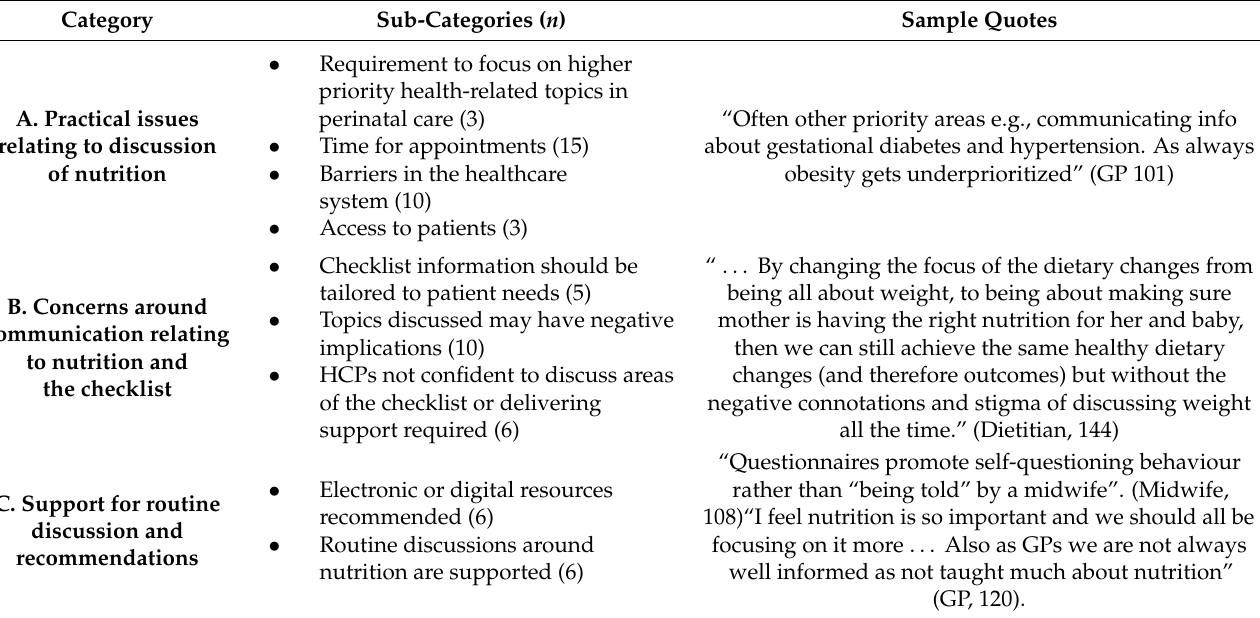
Table 4. Summary of results content analysis on HCP’s views on routine discussion of